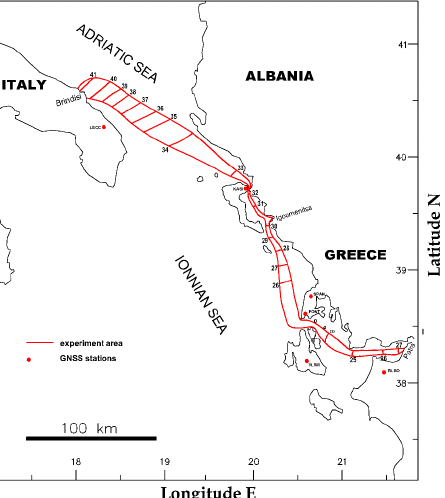
Figure 18. The estimated SST in the area studied. The heights were calculated taking as reference the ellipsoid WGS